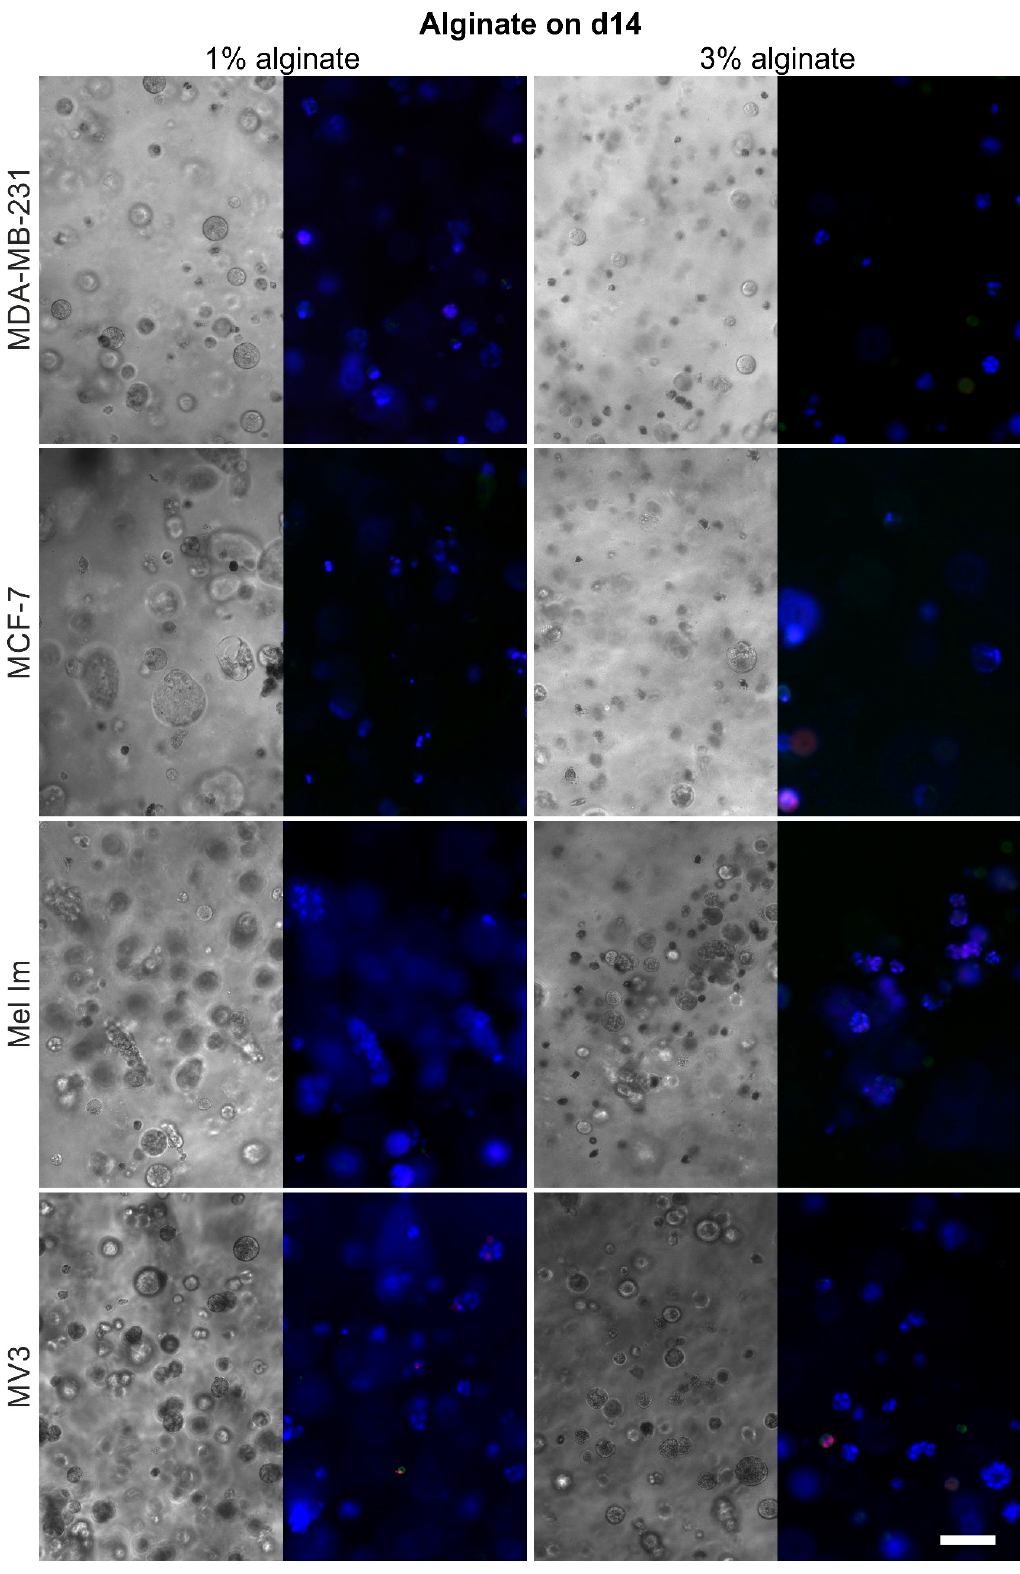
Figure 4. Representative phase contrast and fluorescence pictures of the cell survival and colony formation in alginate on day 14; adjacent pictures show the same position; blue = nucleic acid stain, green = apoptosis, and red = necrosis; scale bar = 100 µm.